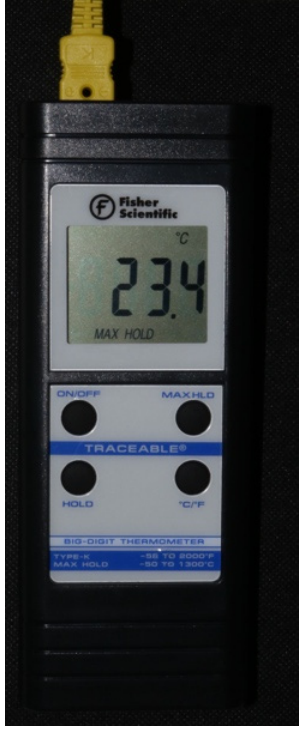
Figure 2. K-type thermocouple (Fisher Scientific 15-078-187, range − 58 to 2000 °F, resolution 0.1°/1°, sampling rate 2.5 times per second) with an ultra-fast response naked bead probe (maximum range 260 °C) which was used to measure the temperature.